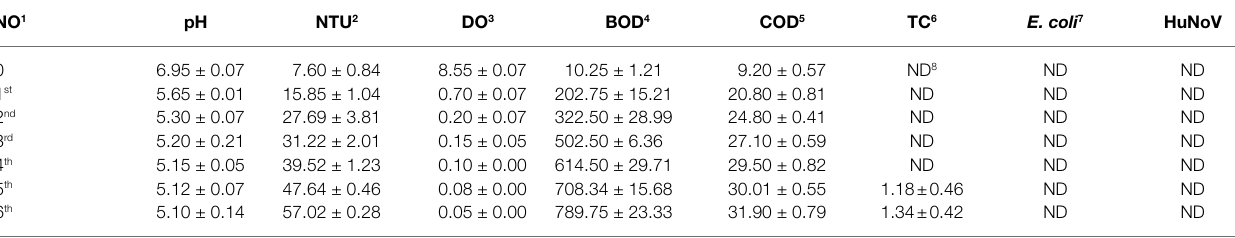
TABLE 1 | Microbial and physicochemical characteristics of brine water.